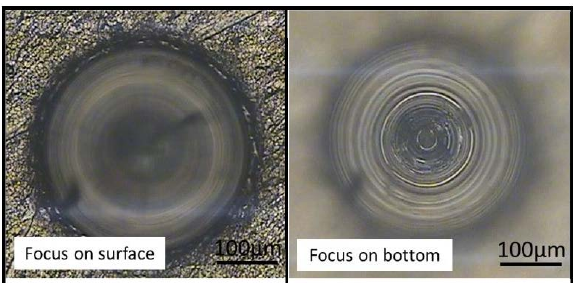
Figure 14. Measurement results by optical microscope.